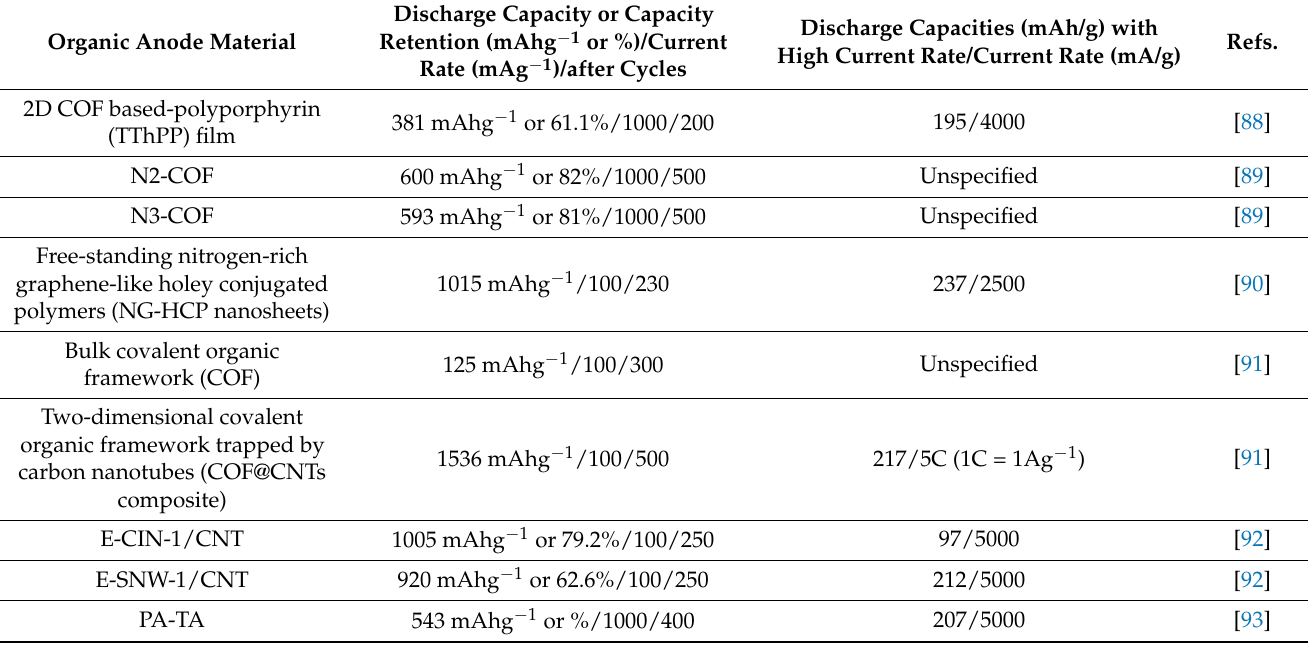
Table 2. Summary of the main electrochemical performance of various COF-based anode